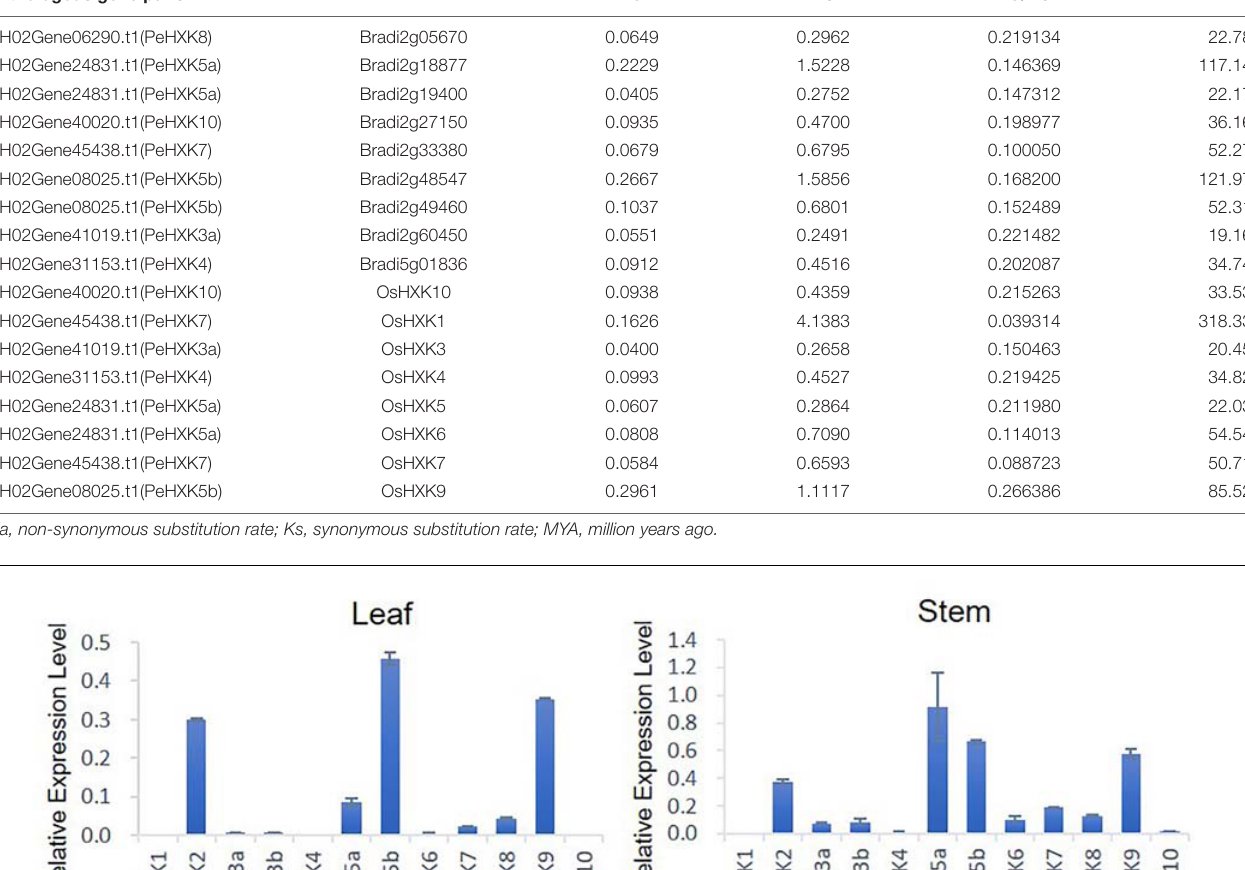
TABLE 2 | Divergence between orthologous gene pairs. Orthologous gene pairs Ka Ks Ka/Ks MYA